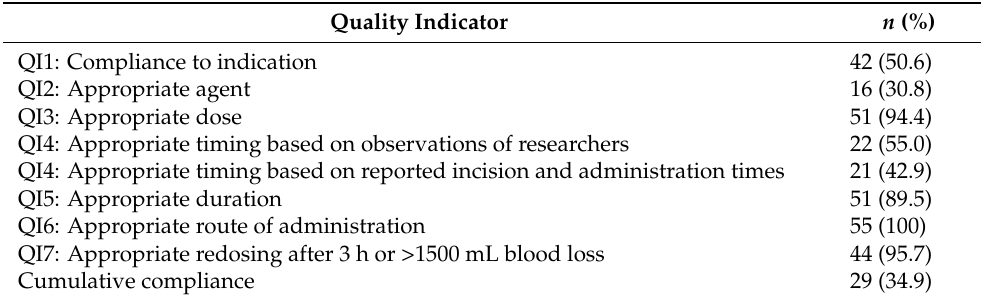
Table 2. Appropriateness of perioperative prophylaxis per quality indicator and cumulative compli-